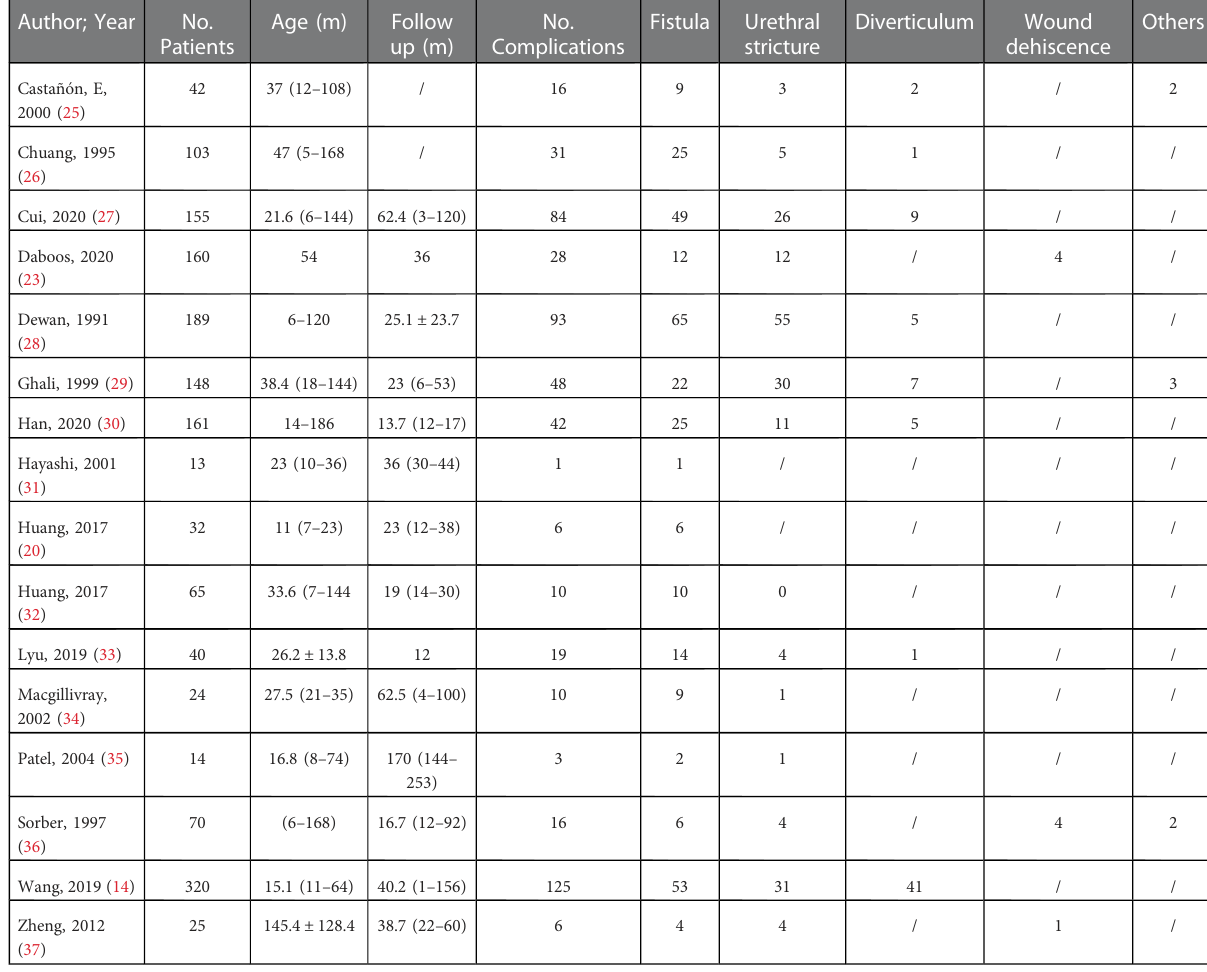
TABLE 3 Literature review of one-stage TPIFU (14, 20, 23, 25 –